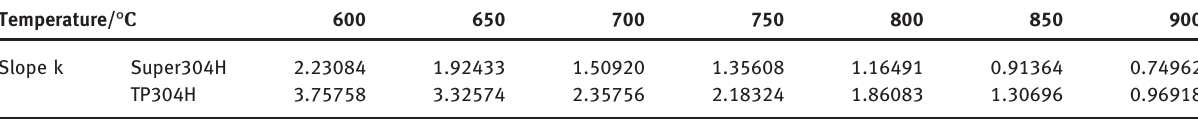
Table 2: Fitting slope k of the linear lines of Z versus x at different temperatures in Super304H and TP304H steels. Temperature/ ° C